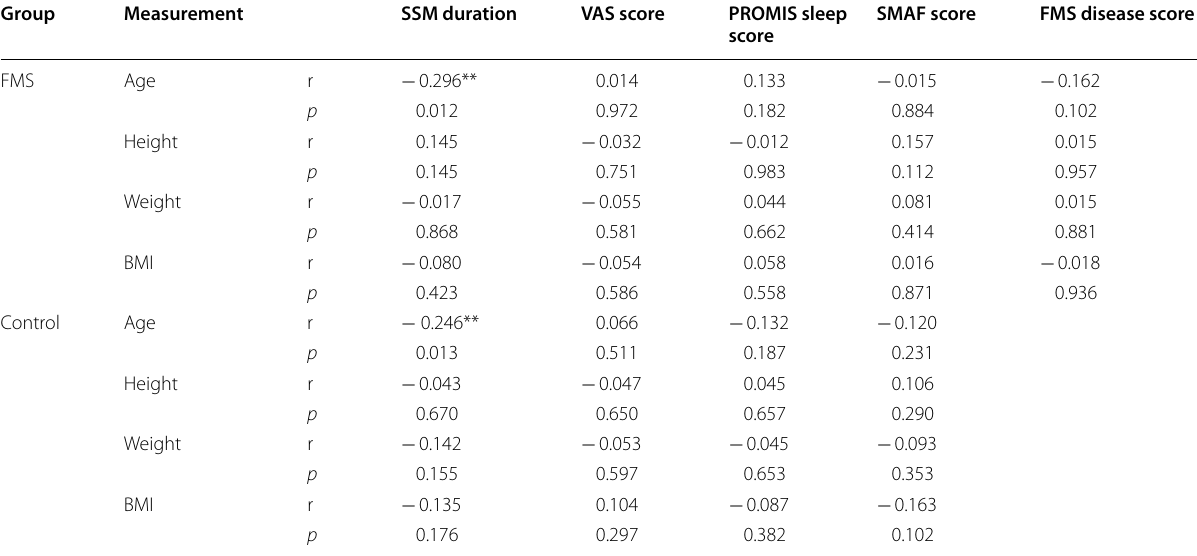
**The r correlation coefficient is significant